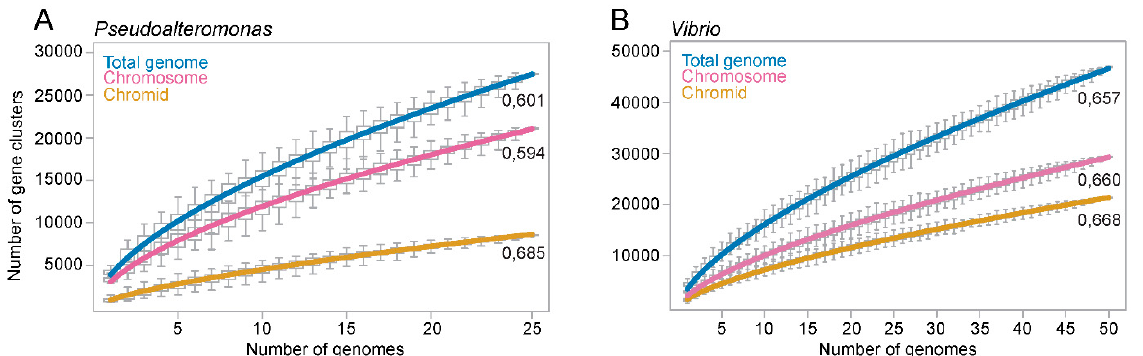
Figure 3. Graphs showing the calculated pangenome sizes of Pseudoalteromonas and Vibrio relative to the number of added genomes. For Pseudoalteromonas ( A ) and Vibrio ( B ), the number of gene clusters continues to grow as more genomes are added to the analysis, which shows that the chromids, chromosomes and total genomes are open. Each data point in the graph is based on the median of pangenome size of 100 randomly generated datasets (strain orders). The Heaps’ exponents are shown associated with each graph and are used to evaluate the openness of the genomes.